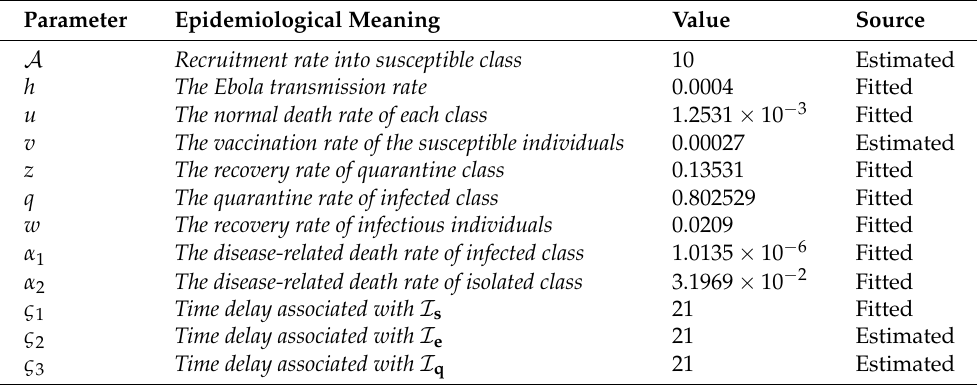
Table 2. The estimated and fitted values of the parameters obtained from fitting the model against the real Ebola cases reported in Western Guinea from the first forty weeks of the 2015 Ebola epidemic [18]. Parameter Epidemiological Meaning Value Source Recruitment rate into susceptible class 10 Estimated The Ebola transmission rate 0.0004 Fitted The normal death rate of each class 1.2531 × 10 − 3 Fitted 0.00027 Estimated 0.13531 Fitted 0.802529 Fitted 0.0209 Fitted The disease-related death rate of infected class 1.0135 × 10 − 6 Fitted 3.1969 × 10 − 2 Fitted Fitted